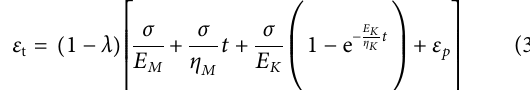
FIGURE 4 | Numerical model of